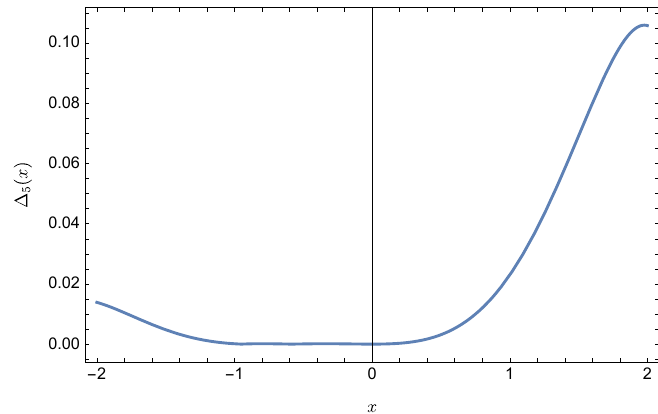
Figure 10. Error ∆ 5 of approximation y 5 ( x ) .